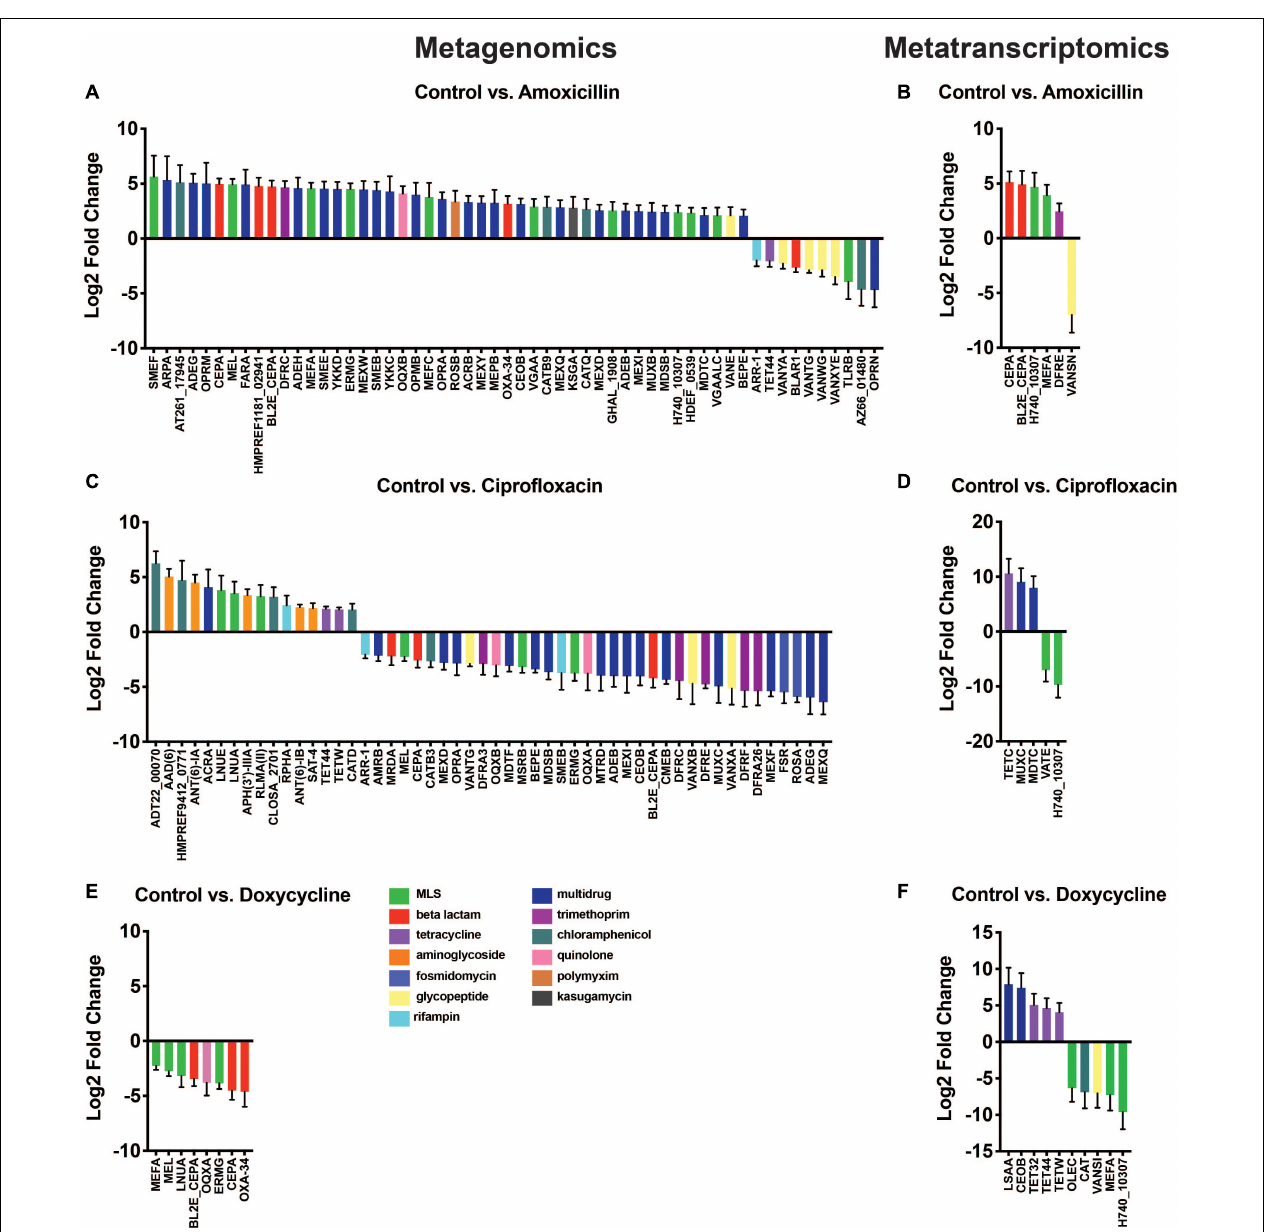
FIGURE 4 | Differential abundance of antibiotic resistance genes. Changes in ARG abundances after antibiotic treatment observed in metagenomic (A,C,E) and metatranscriptomic data (B,D,F) . Bars represent change in gene/transcript abundance after exposure to antibiotics displayed as log 2 fold change ± standard error (log 2 FC ≥ 1.5/ ≤ –1.5 and padj < 0.05) (Full ARG class counts available in Supplementary Table S3